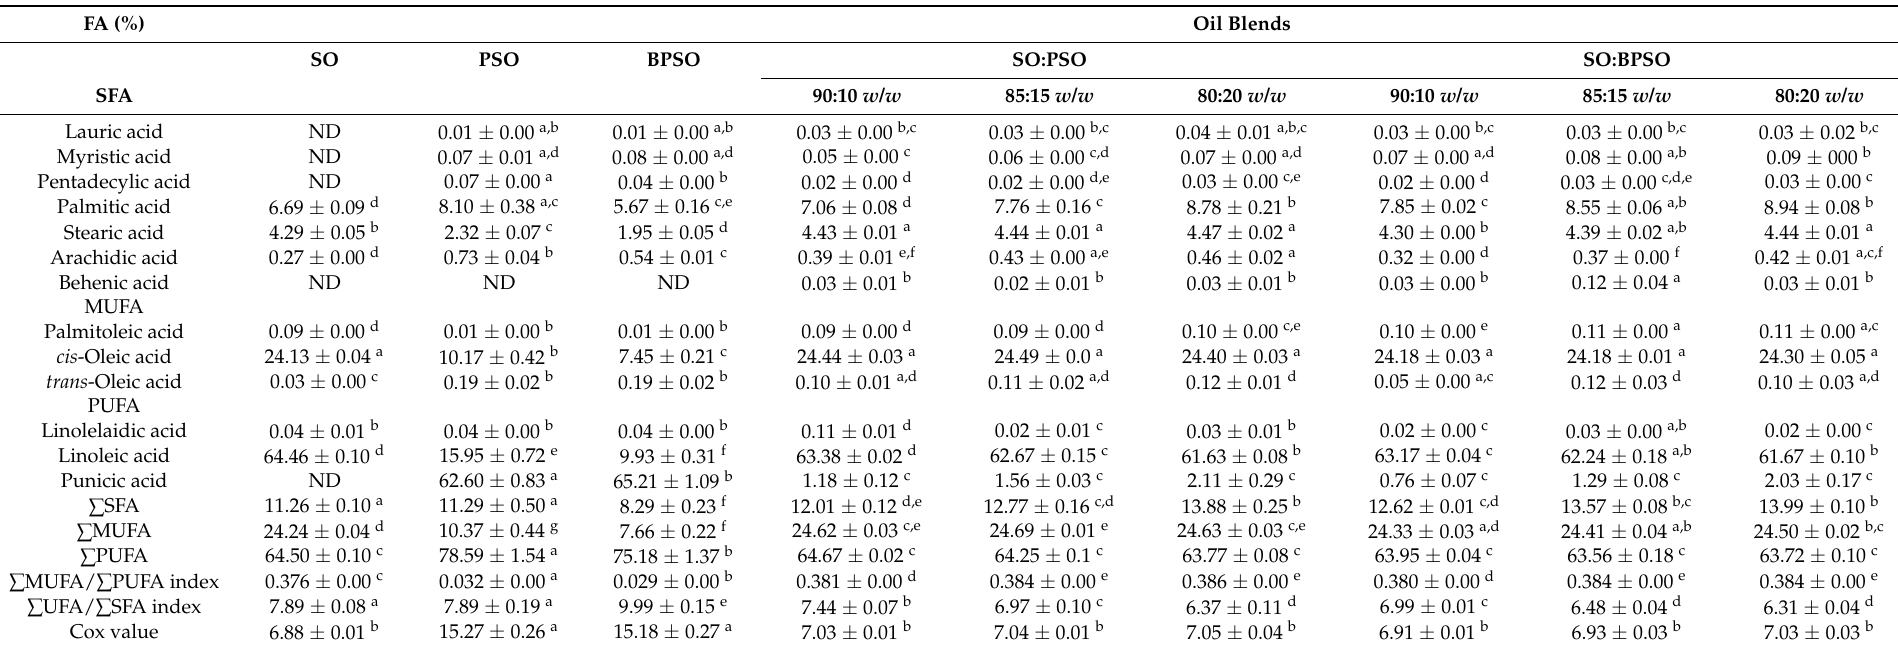
Table 1. Fatty acid composition of sunflower oil, pomegranate seed oil, and oil blends.